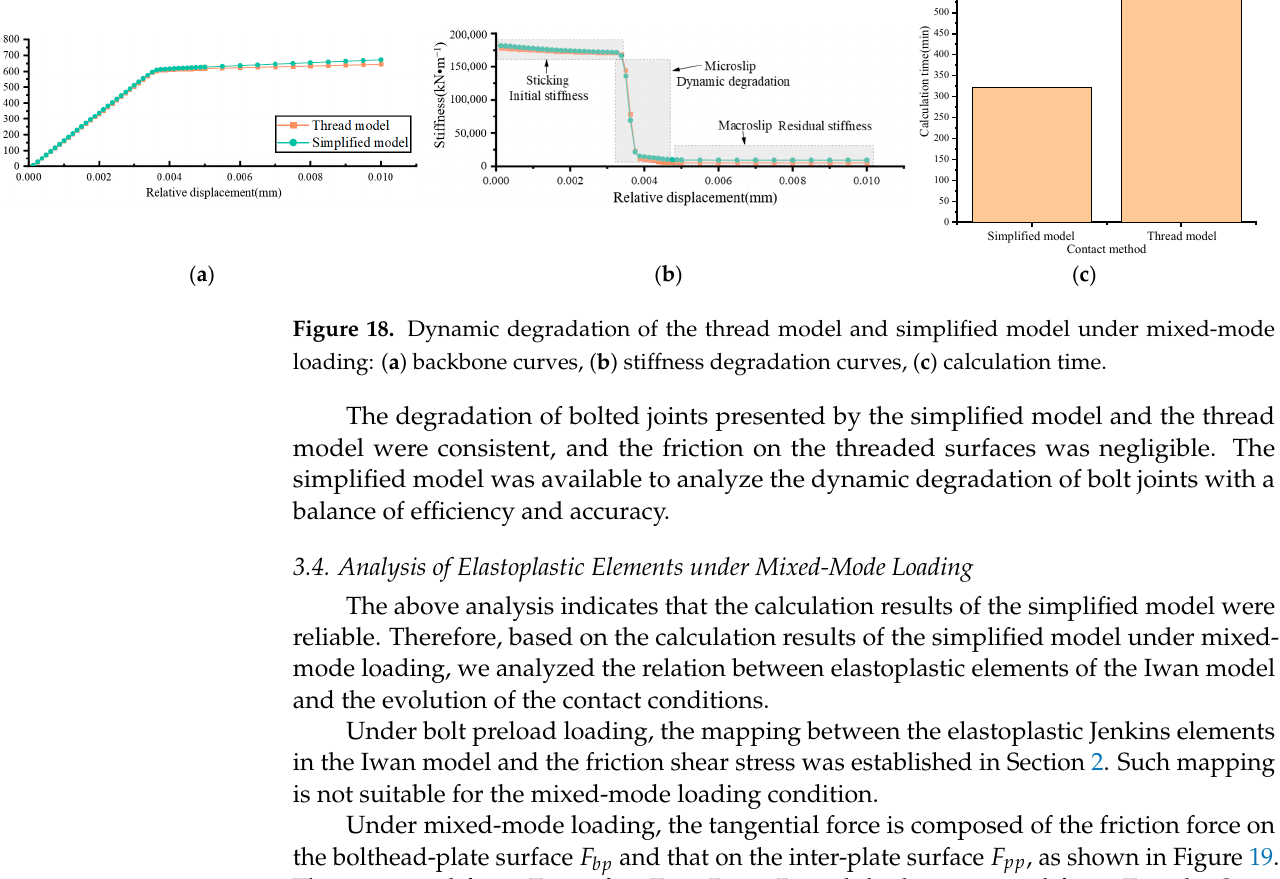
Figure 17. Pressure distribution on the inter-plate surface: ( a ) scanning paths on the inter-plate surface, ( b ) the pressure distribution of the two models.